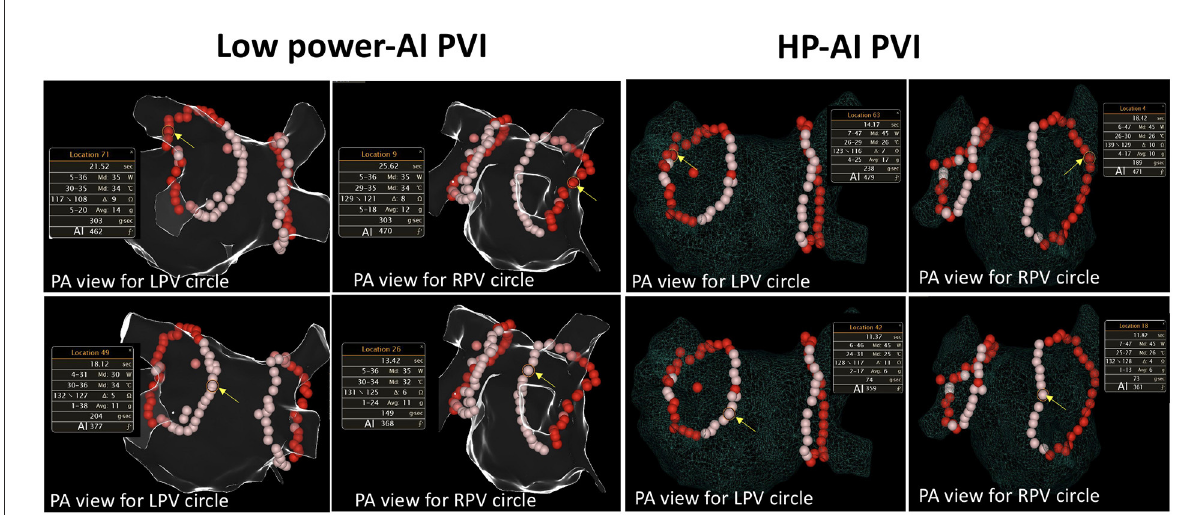
FIGURE1 Examples of HP-AI- and low-power AI-guided PVI procedures. The detailed ablation parameters of the highlighted (with yellow arrow) lesion are presented. The red-colored-tags represent lesions with an AI ranging from 400 to 500. Tags in pink represent lesions with an AI ranging between 350 and 399. Note that the power delivered between the two groups was different (35 and 45W, respectively). AI, Ablation index, calculated with contact force, power delivered, and ablation time. PA view, posterioanterior view; RPV, right pulmonary vein; LPV, left pulmonary